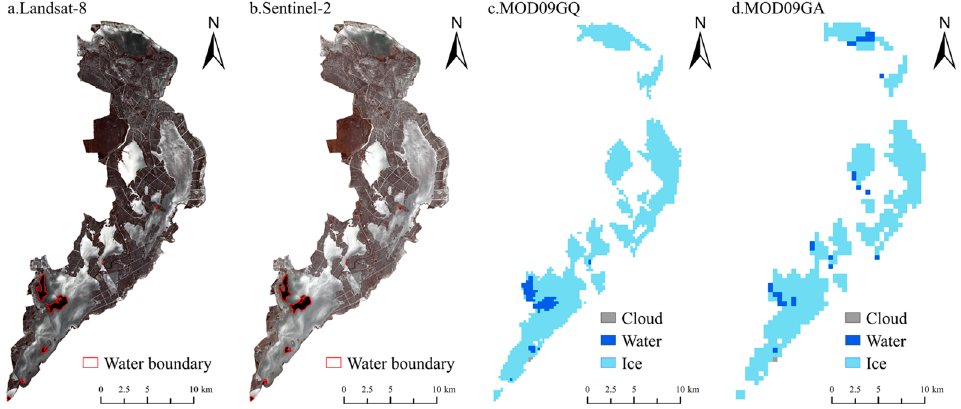
Figure 9. Comparisons of the water area extracted by Landsat-8, Sentinel-2, and MODIS products (selected for 2 March 2021).